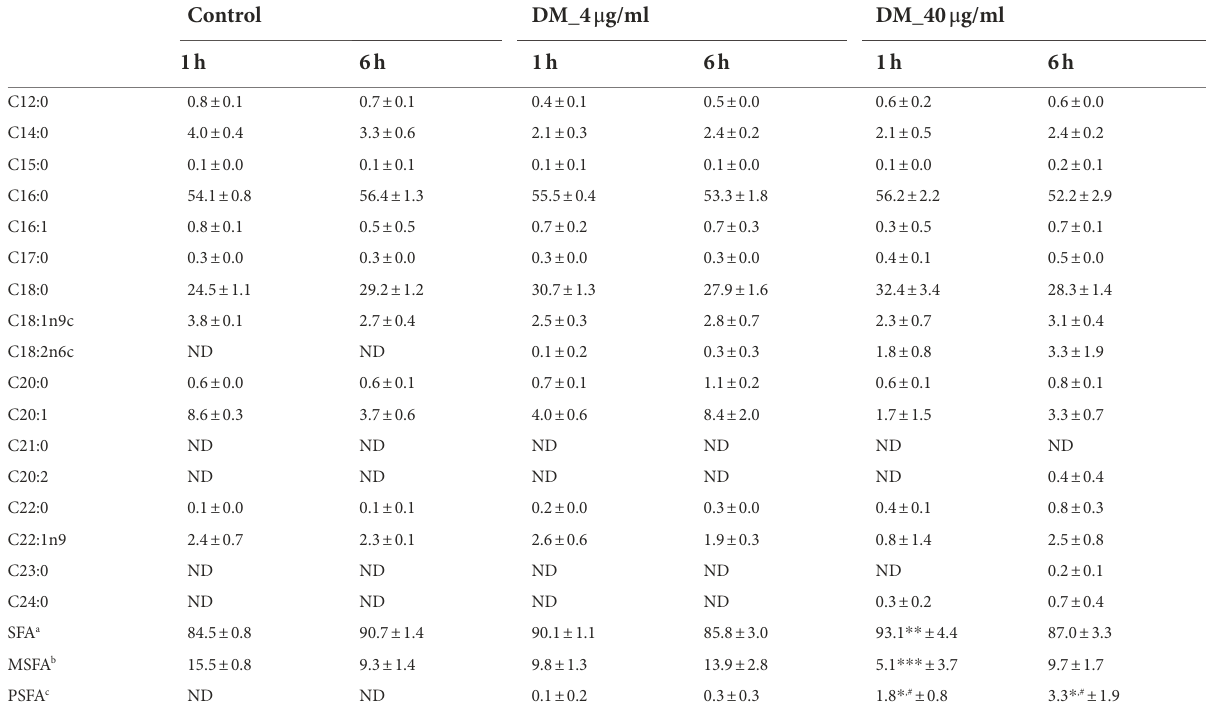
TABLE 1 Fatty acid composition of Streptococcus mutans UA159.